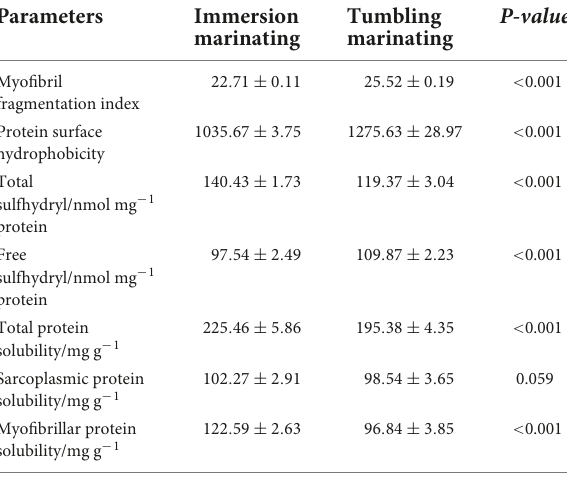
TABLE 3 Effect of vacuum tumbling and immersion marination on protein